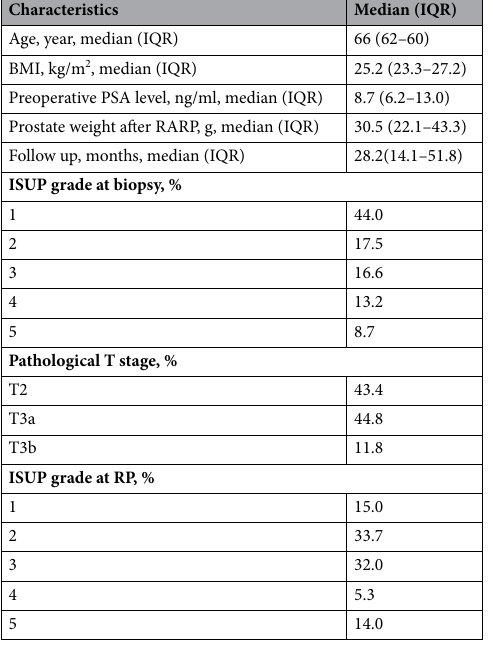
Table 1. Baseline characteristics of 419 patients treated with robotic prostatectomy. RARP robot-assisted radical prostatectomy, BMI body mass index, PSA prostate-specific antigen, ISUP International Society of Urological Pathology, RP radical